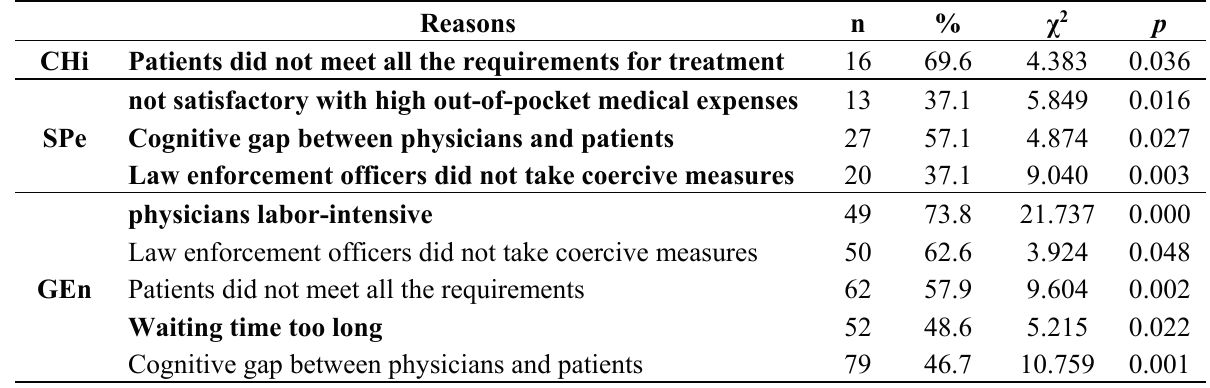
Table 6. Reasons for WPV according to medical staff who had experienced